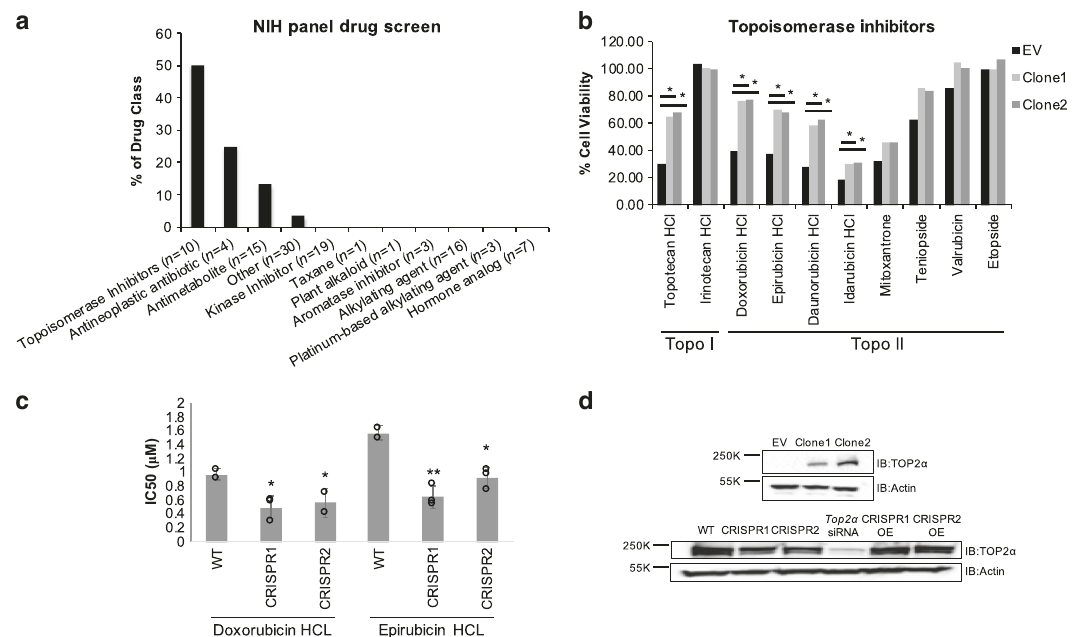
Fig. 6 RAMS11 expression alters sensitivity to topoisomerase inhibitors. a Cell viability assay comparing HT29 empty vector cells with RAMS11 overexpressing cell lines showing signi fi cant resistance to various drug classes. b RAMS11 overexpressing cells have increased cell viability compared with empty vector cells in fi ve of ten topoisomerase (Topo) inhibitors. c IC50 values of RAMS11 CRISPR KO cell lines ( n = 3) with decreased viability to doxorubicin hydrochloride (HCl) and epirubicin HCl drug treatments. d Protein expression of Top2 α in (top) RAMS11 overexpressing cell lines and (bottom) CRISPR KO cell lines, TOP2 α siRNA control cells, and CRISPR cell lines overexpressing (OE) RAMS11 . Band intensities were quanti fi ed from the digital image in ImageJ and are shown normalized to the empty vector or wild-type lane for each target. Samples derived from the same experiment and blots were processed in parallel. All data are presented as mean values±s.d. Experiments repeated three times. *Fold change>1.5. Source data are provided as a Source Data